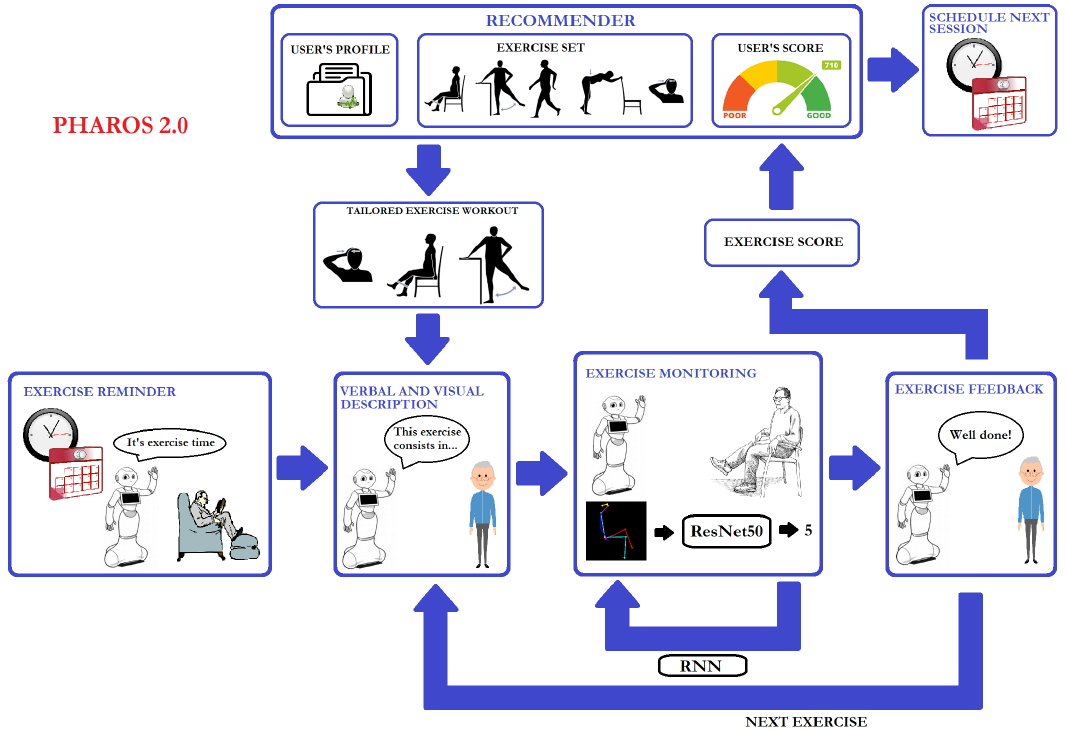
Figure 1. Workflow of PHAROS